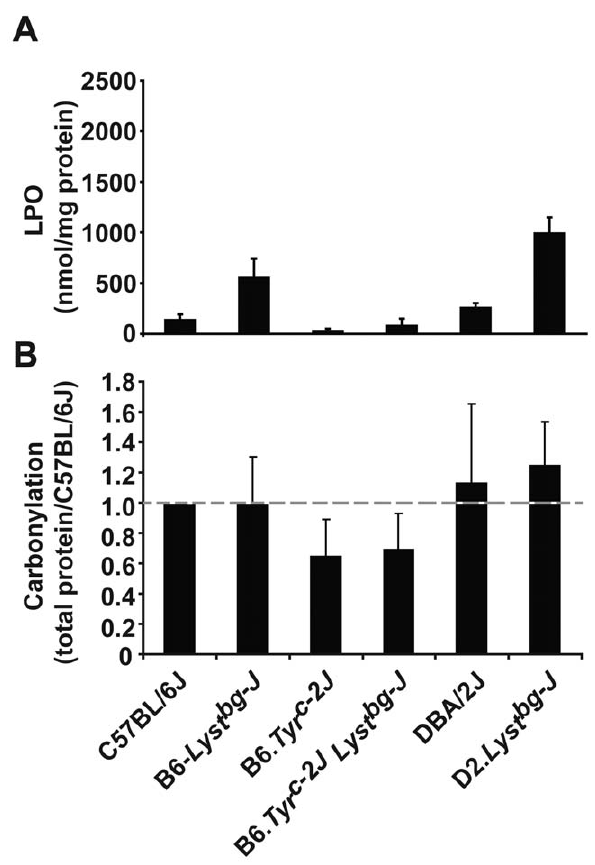
Figure 5. Lyst mutation leads to an increase in the levels of lipid hydroperoxides. (A) Lipid hydroperoxide levels in the iris according to genotype. (B) Protein carbonylation levels in the iris according to genotype. Mean 6 SD; n =3 for each combination of genotype and strain.